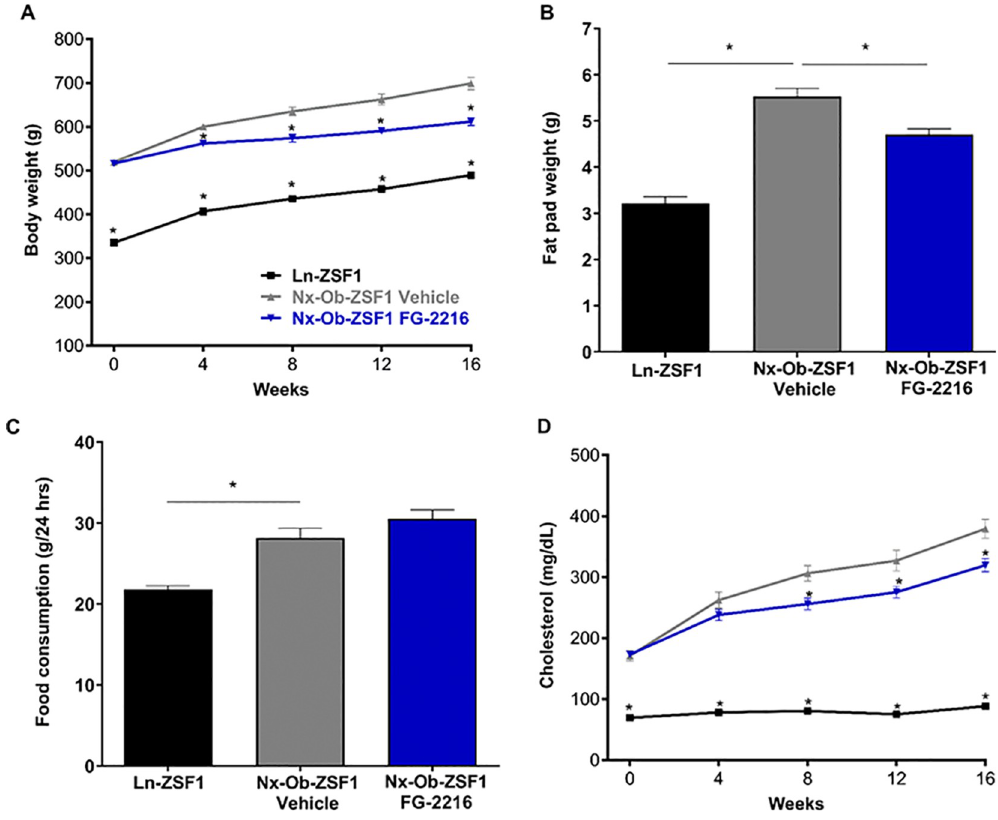
Fig 6. FG-2216 reduced obesity in Nx-Ob-ZSF1 rats. Rats were weighed at regular intervals during the treatment period ( A ). Fat pads were harvested after 18 weeks of treatment and weighed ( B ). After 17 weeks of treatment, food consumption was measured over 48 hours encompassing a dosing and a non-dosing day ( C ). Blood was collected every four weeks during the treatment period to determine serum cholesterol ( D ). Values represent mean ± SEM (n = 8–12). � P < 0.05 vs . Nx-Ob- ZSF1 Vehicle (Bonferroni test for A and D; Dunnett’s test for B and C).